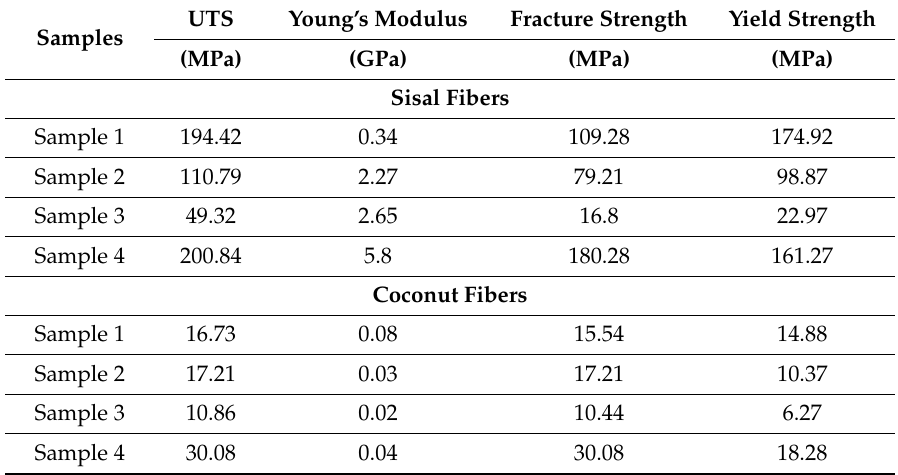
Table A1. Mechanical properties of the samples of coconut and sisal.